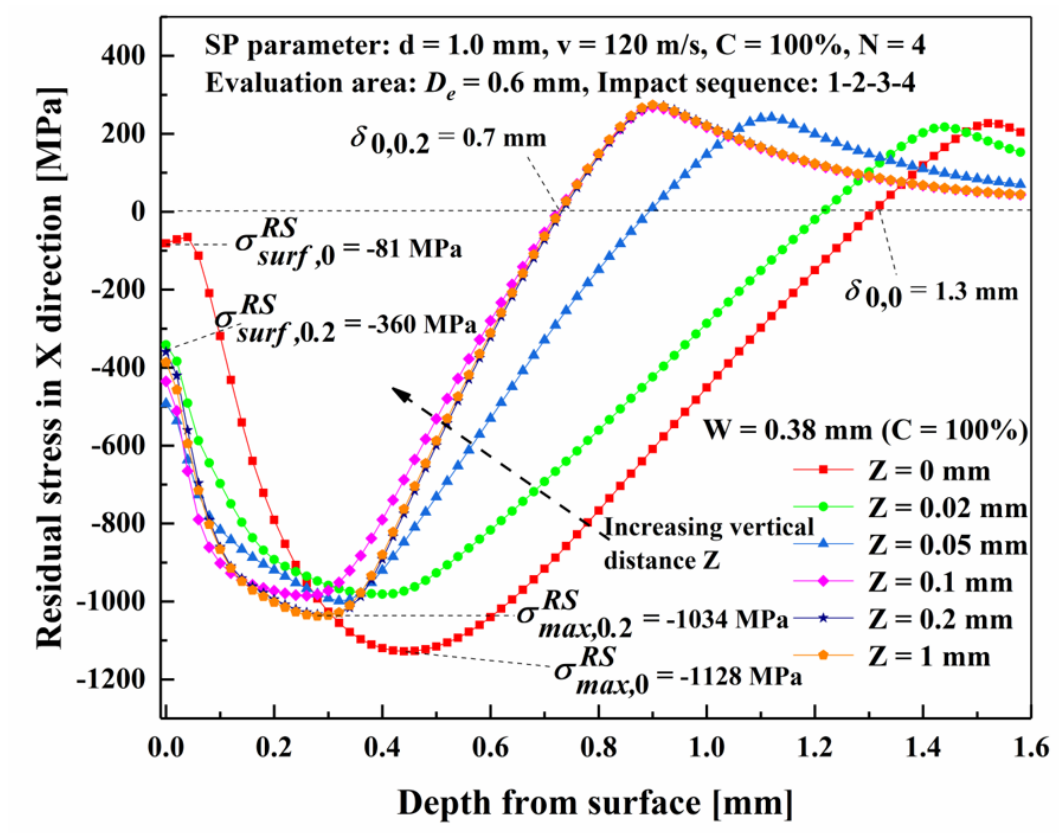
Figure 6. The residual stress depth profiles of five different vertical distance between shots (Z) SP models in the condition of V = 120 m/s, d = 1.0 mm and C = 100%.